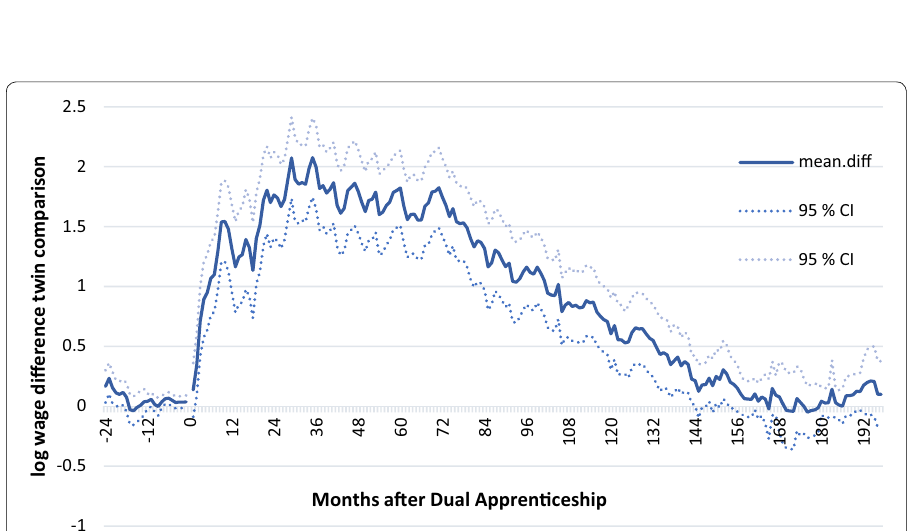
Fig. 11 Earnings differences between alternative comparison groups (181 foremen and 350